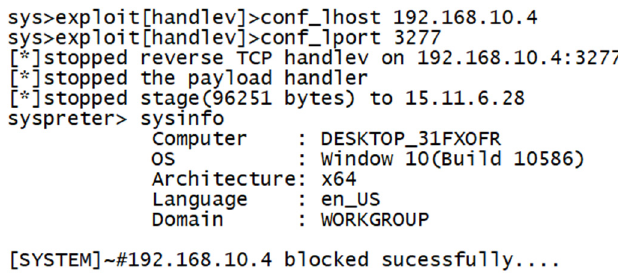
Figure 6. Blocking of the permanent IP address.